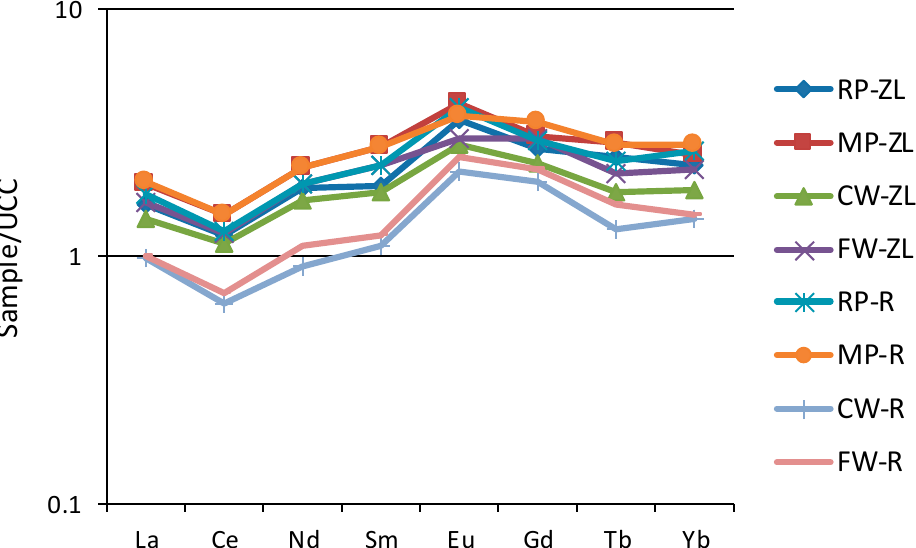
Figure 3. The rare-earth element (REE) patterns normalized to the upper continental crust (UCC) of raw phosphate (RP), marketable phosphate (MP), fine waste (FW), and coarse waste (CW) from M’Dhilla-Zone L (ZL) and Redeyef (R).